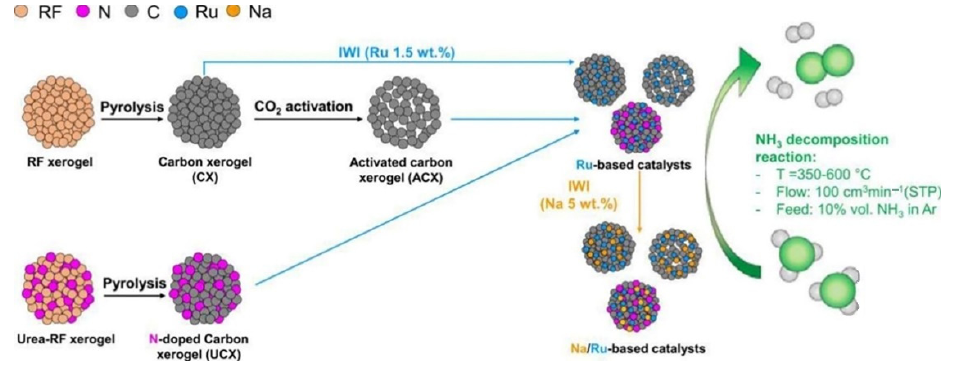
Figure 31. Development process of resorcinol–formaldehyde carbon xerogel for Ru-based catalyst. Reprinted with permission [125].